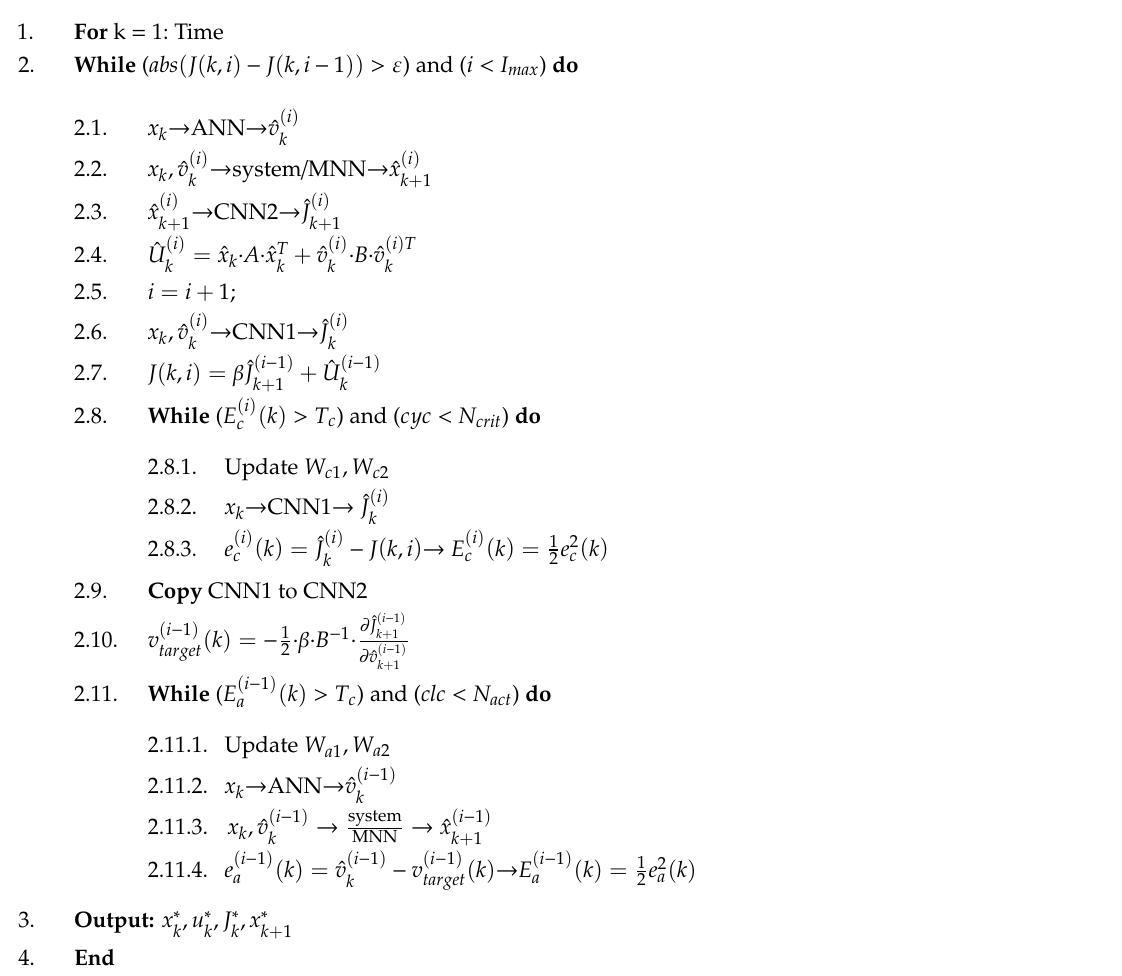
Algorithm 1. The training process of